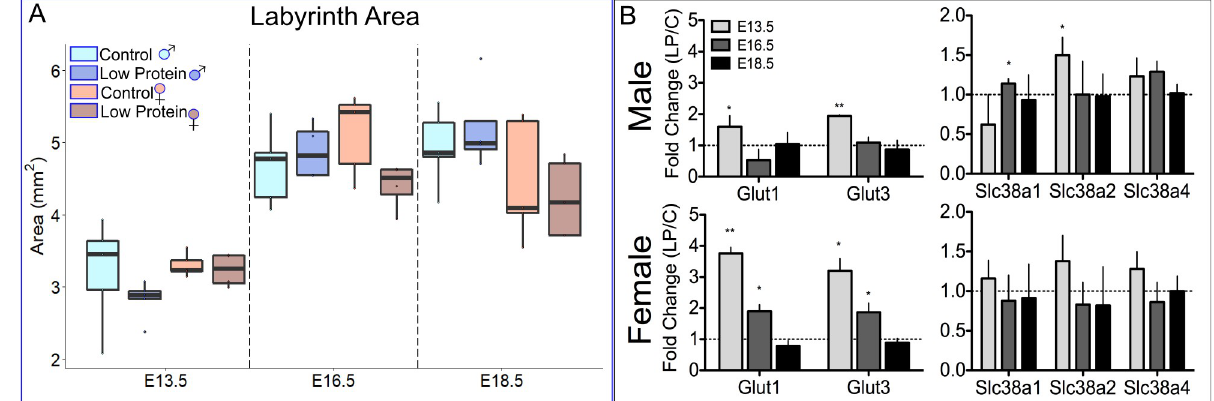
Fig 4. Labyrinth growth in low protein pregnancies is mediated by trophoblast hypertrophy and nutrient transport function. (A) Total labyrinth area separated by diet and sex (n = 4–5). (B) Glucose and amino acid transporter expression in male and female placentas. Fold change in protein restricted placentas (bars) relative to control diet placental expression (dotted line). � p < 0.05; �� p < 0.01 (n = 3).